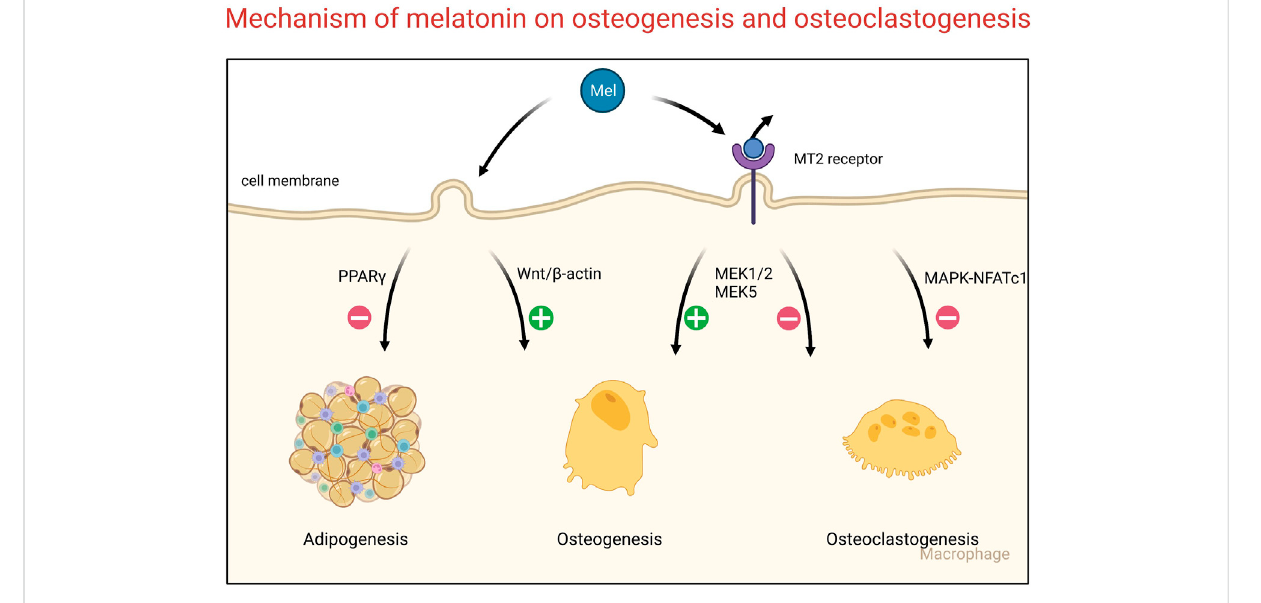
FIGURE 1 Signaling pathways of bone remodeling regulated by